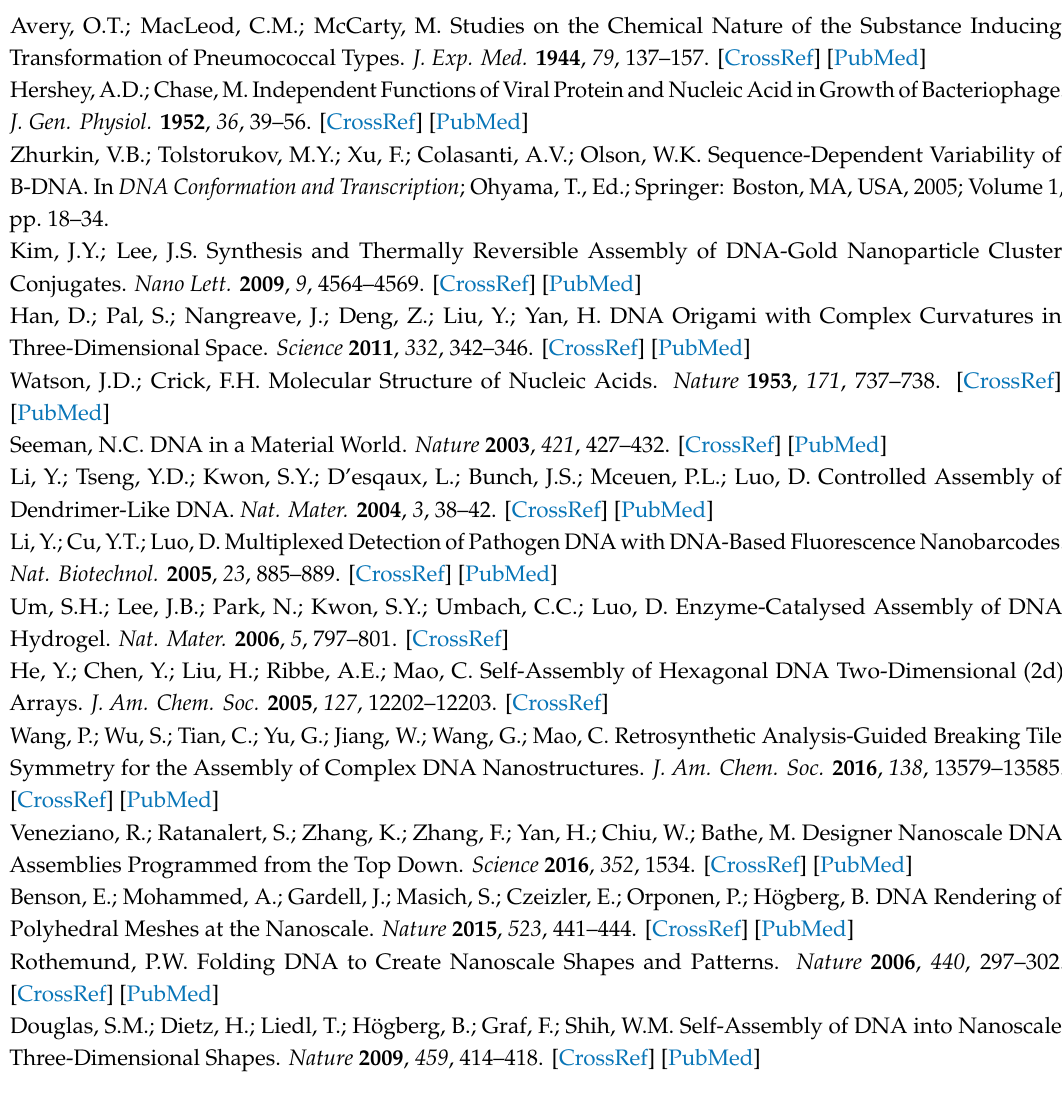
Figure S1: Size distribution of the DNAp-based netropsin release systems. (DNAp: black, DNAp@Ne: blue, low-CaDNAp@Ne: light green, high-CaDNAp@Ne: green); Figure S2: Cell viability when exposed to DNAp-based netropsin release systems. The viability of the CaDNAp@Ne and control groups was tested using the normal endothelial cell line HUVEC and the cancer cell line